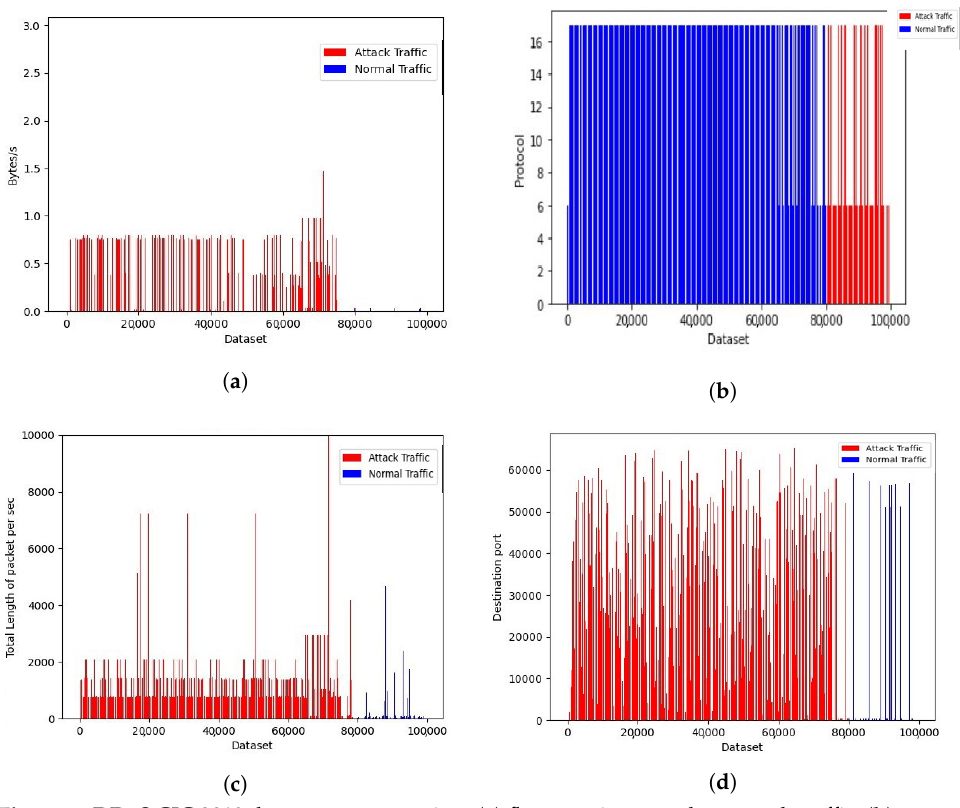
Figure 8. DDoS CIC 2019 dataset representation: ( a ) flow rate in normal vs. attack traffic; ( b ) protocol used; ( c ) total length of packet per sec; and ( d ) destination port used.